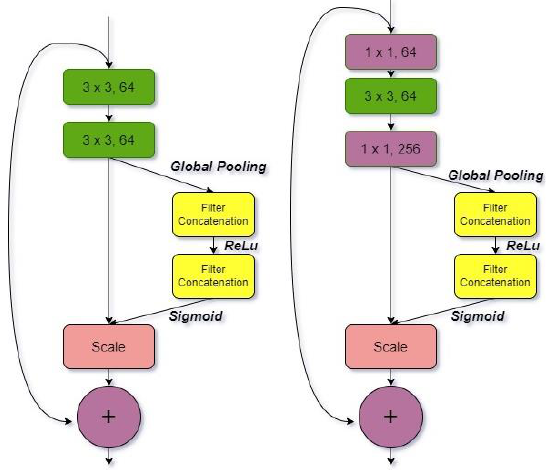
Figure 2. ResNet-164 architecture.